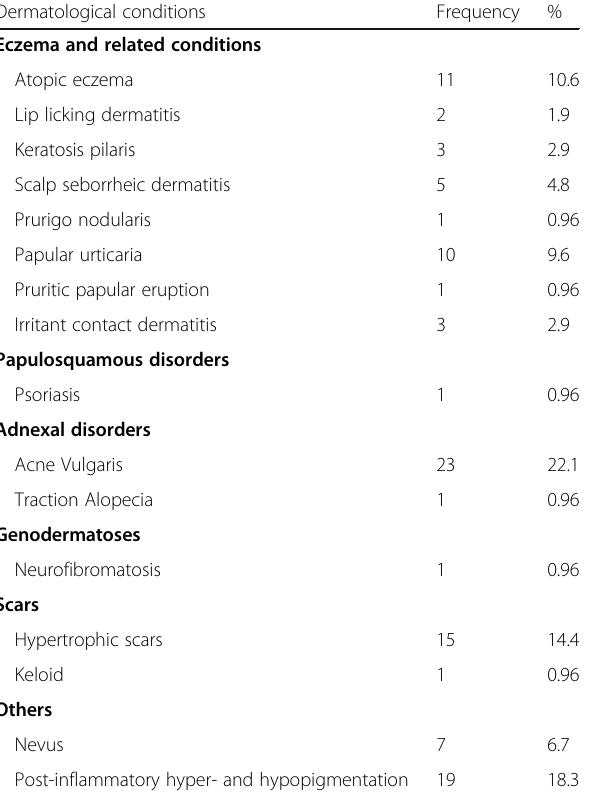
Table 3 Pattern of non- infectious dermatological conditions among children living in orphanage centres in Dar es Salaam ( n